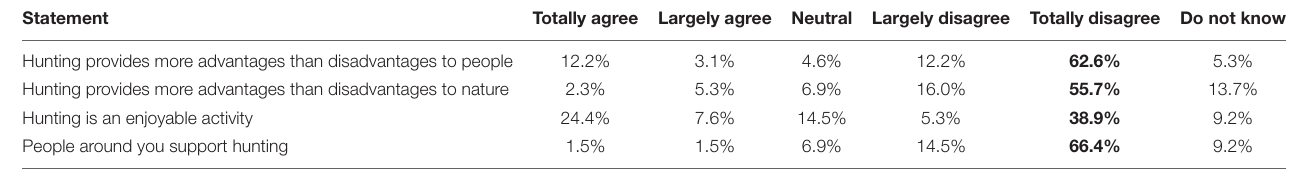
TABLE 2 | Attitudes toward hunting held by interviewees on Hainan ( N = 131).